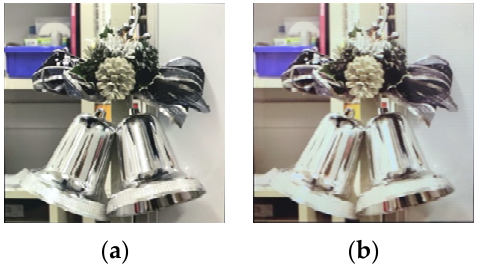
Figure 17. Gloss-corrected image with the best evaluation. ( a ) Xperia1, threshold:0.9, parameter:3.0; ( b ) FireHD8, threshold:0.85, parameter:0.5.